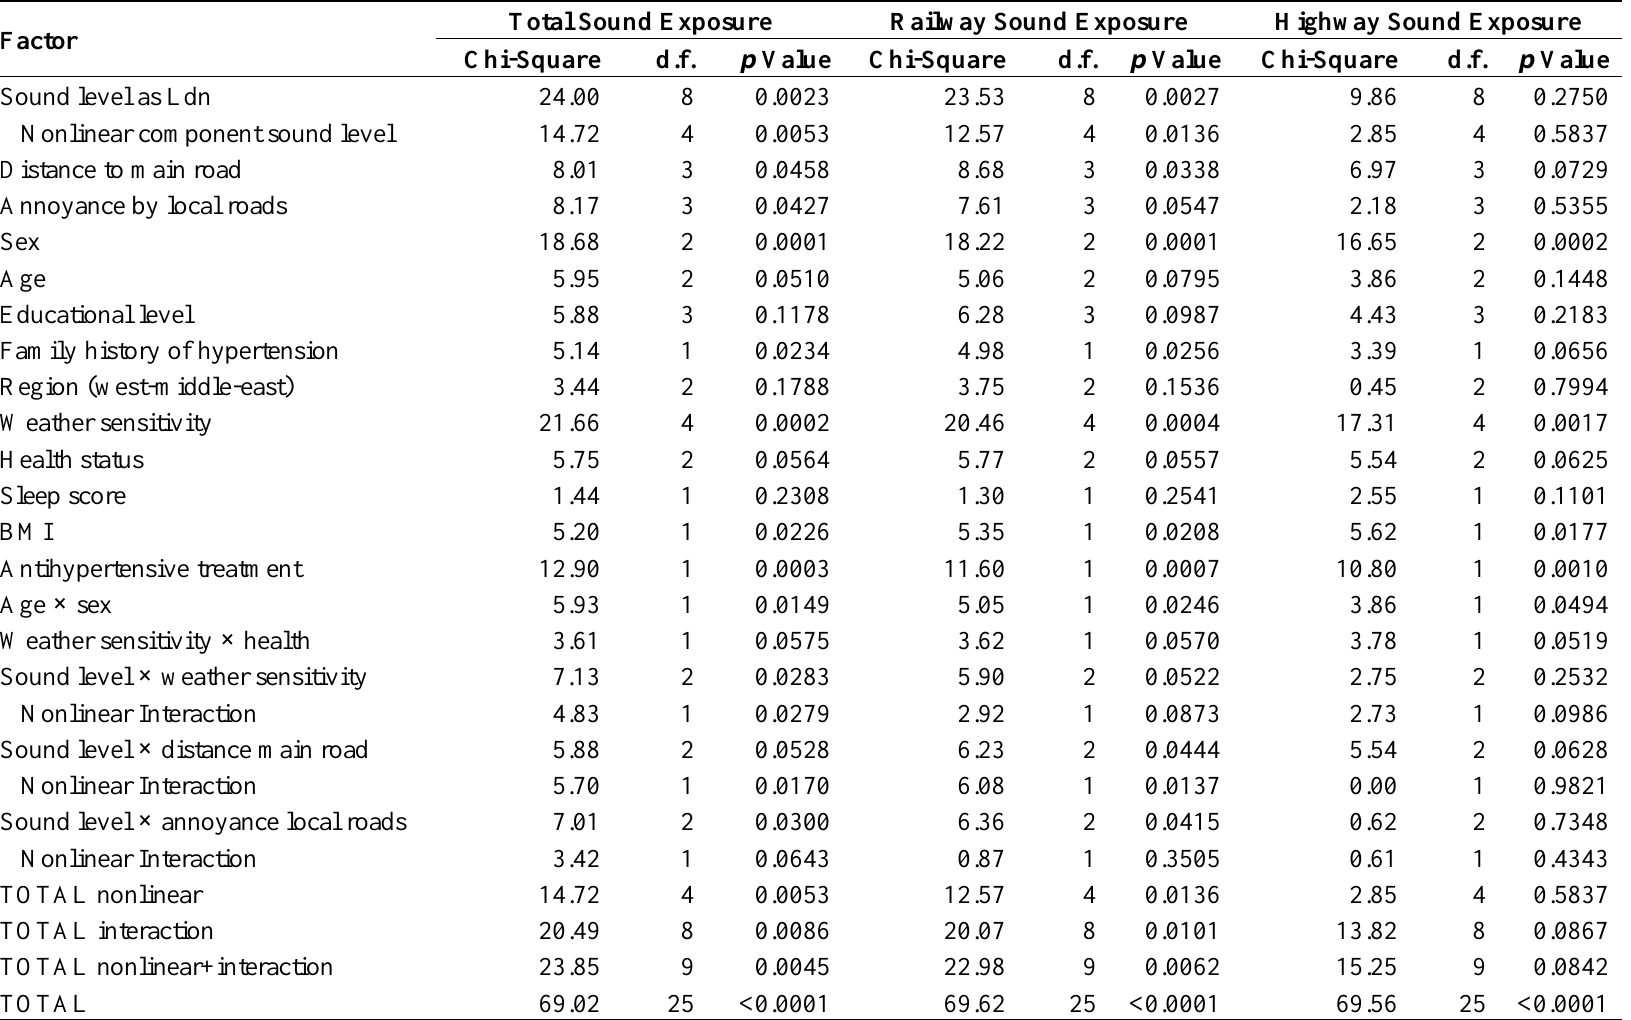
Table 3. Multiple logistic regression results for total, rail and highway sound exposure models with reported hypotension, including thirteen covariates and five interaction terms (N =